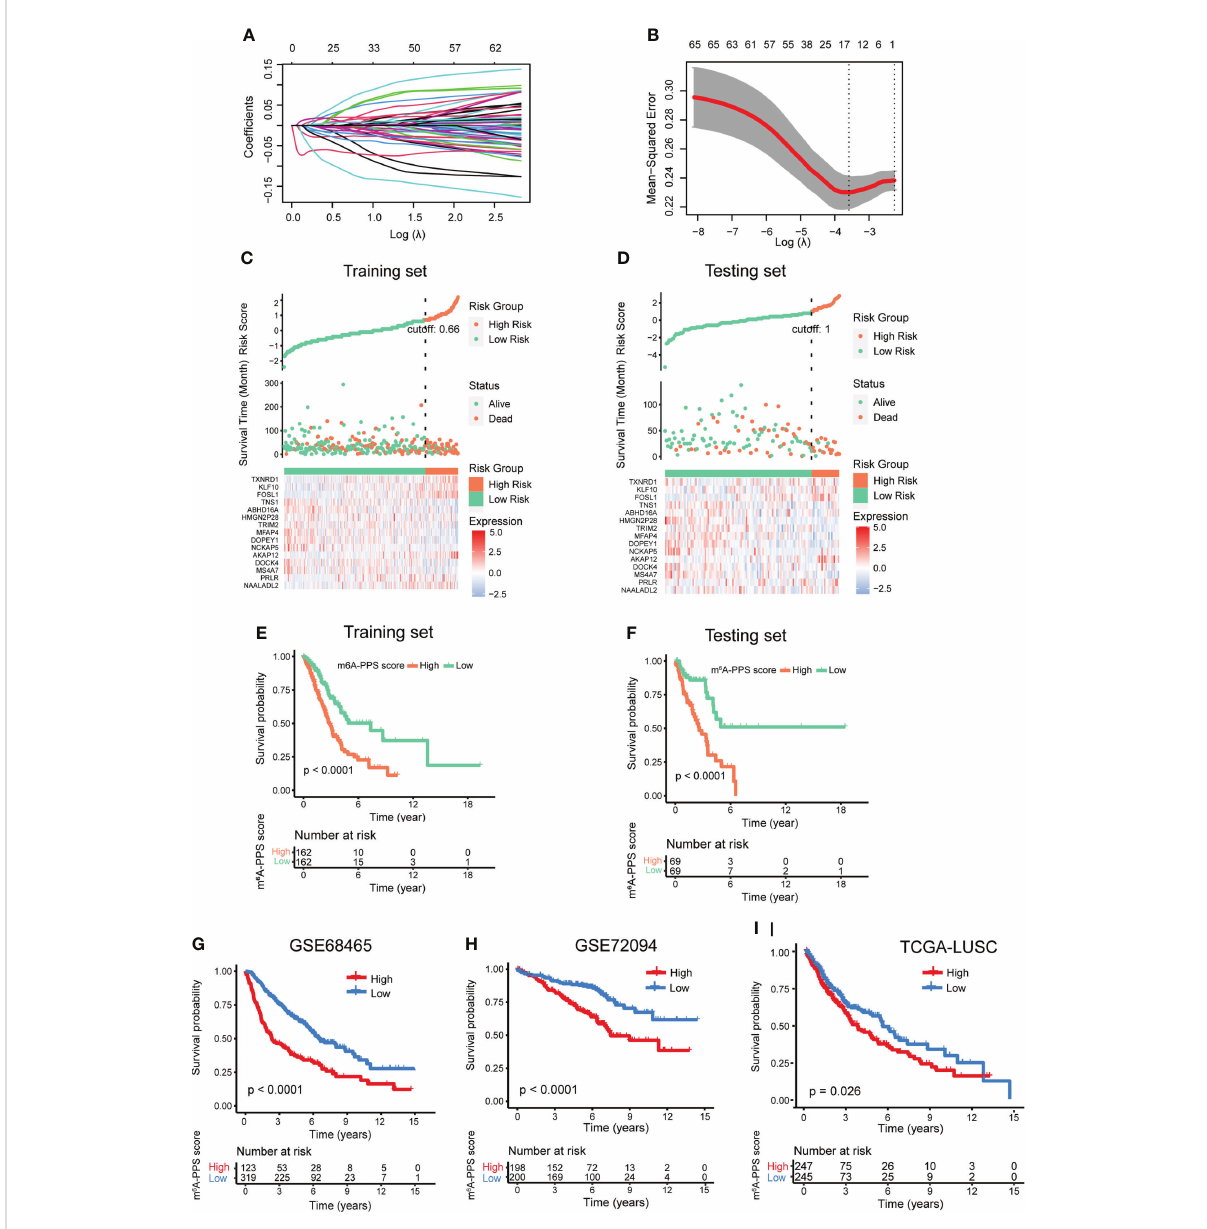
FIGURE 3 Development and validation of the m 6 A-PPS and evaluation of the prognostic value. (A) The tuning parameters [log(lambda)] of OS-related genes were selected to cross-verify the error curve. According to the minimal criterion and 1-se criterion, perpendicular imaginary lines were drawn at the optimal value. (B) The LASSO coef fi cient pro fi le of 15 OS-related m 6 A-regulated genes and perpendicular imaginary lines were drawn at the value chosen by 10-fold cross-validation. (C, D) Distribution of risk score, survival status of LUAD patients and heatmap expression of 15 m 6 A-regulated genes in the training set (C) and testing set (D) . (E, F) Kaplan – Meier curves of OS for LUAD patients strati fi ed by the median m 6 A-PPS score in the training set (E) and testing set (F) . (G – I) Validation of the m 6 A-PPS model in three independent